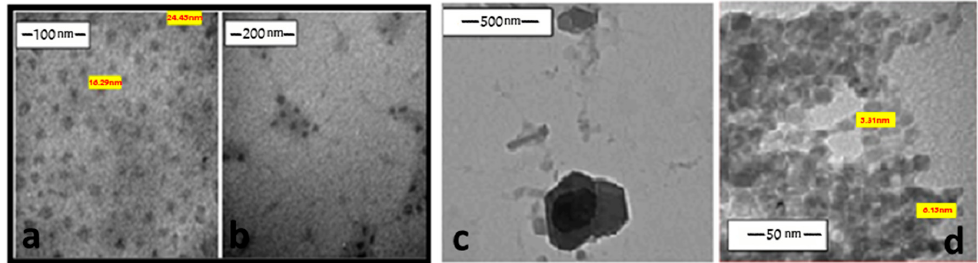
Figure 5. TEM images of nano copper complex with 10 − 3 M CTAB ( a , b ), nano nickel complex with 10 − 2 MCTAB ( c ) and nano zincwith 10 − 2 MCTAB ( d ).